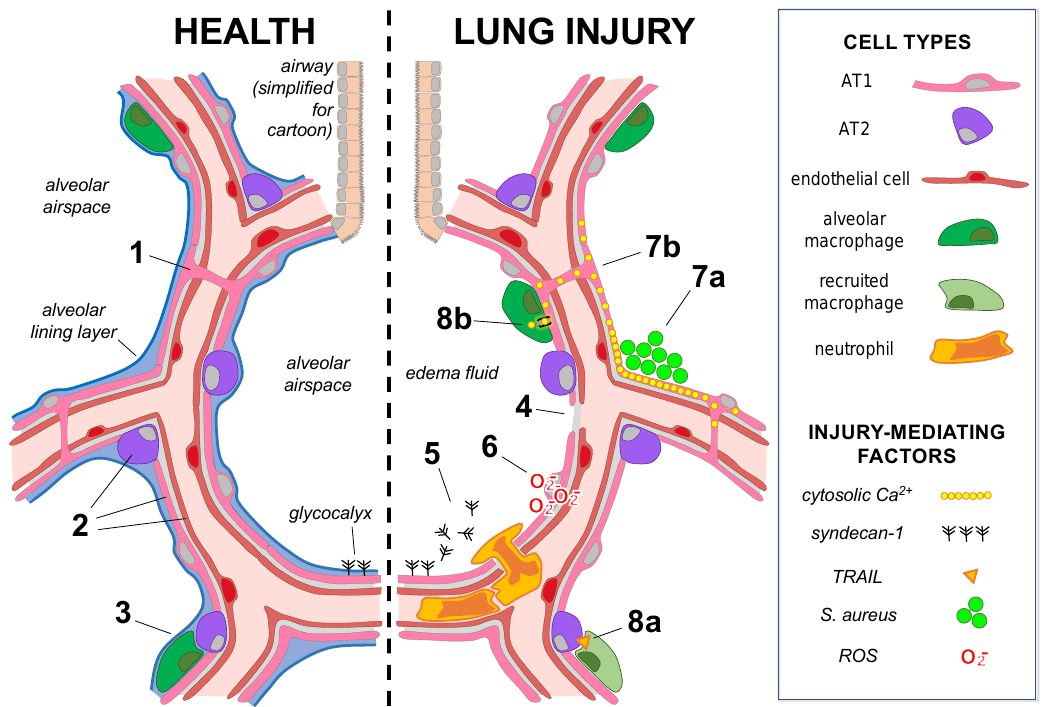
Figure 1. Mechanisms of alveolar epithelial health and lung injury. The cartoon shows alveoli under baseline conditions ( left ) in which alveolar epithelial type 1 ( AT1 ) and type 2 ( AT2 ) cells underlie the alveolar lining layer. The glycocalyx extends from the epithelial surface. (Note: the glycocalyx size is exaggerated.) AT1 cells span multiple alveoli through the pores of Kohn in human lungs ( 1 ), and AT1, AT2, and microvascular endothelial cells ( 2 ) are heterogeneous groups comprised of subpopulations. AT2-cell-derived GM-CSF ( 3 ) maintains the lung resident alveolar macrophage population in healthy adult lungs. In lung injury ( right ), alveolar epithelial cell damage, junctional and Na,K-ATPase protein loss ( 4 ), and surfactant dysfunction lead to edema fluid accumulation in airspaces. Here, we highlight examples of the cell-autonomous and extrinsic interactions by which the alveolar epithelium responds to injury (detailed in Section 3). ( 5 ) Alveolar responses to injury : Glycocalyx shedding promotes airspace neutrophil recruitment and activation. ( 6 ) Epithelial–endothelial crosstalk : ROS release from the injured alveolar epithelium causes mitochondrial depolarization and cytoskeletal destabilization in the epithelium-adjacent endothelium. ( 7a,b ) Alveolar epithelial cell–cell communication : ( 7a ) Inhaled S. aureus form microaggregates in structural alveolar niches, where localized increases in cytosolic Ca 2+ spread ( 7b ) through alveolar epithelial gap junctions to induce widespread alveolar edema. ( 8a,b ) Reciprocal signaling between the alveolar epithelium and immune cells : ( 8a ) Interferon alpha secretion by influenza-infected AT2 cells induces secretion of TNF-related apoptosis-induced ligand (TRAIL) by recruited macrophages, inducing signaling to the uninfected alveolar epithelium, which leads to epithelial loss of Na,K-ATPase protein. ( 8b ) Alveolar macrophages directly interact with the alveolar epithelium via gap junctions to communicate anti-inflammatory cytosolic Ca 2+ signals, limiting lung injury.